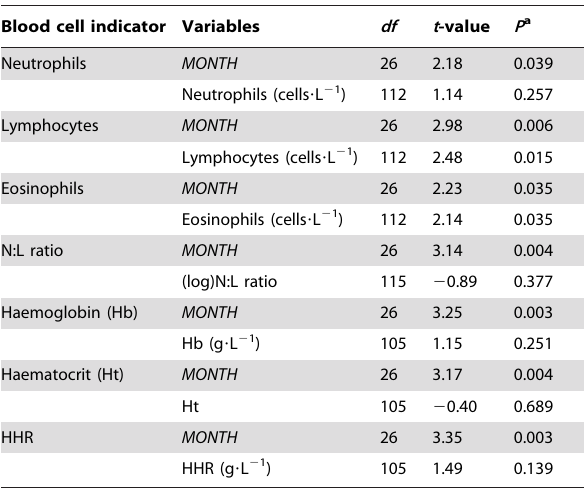
Table 5. Analysis of the difference between expected (number of traps set) and observed captures of agile antechinus as a function of microhabitat.